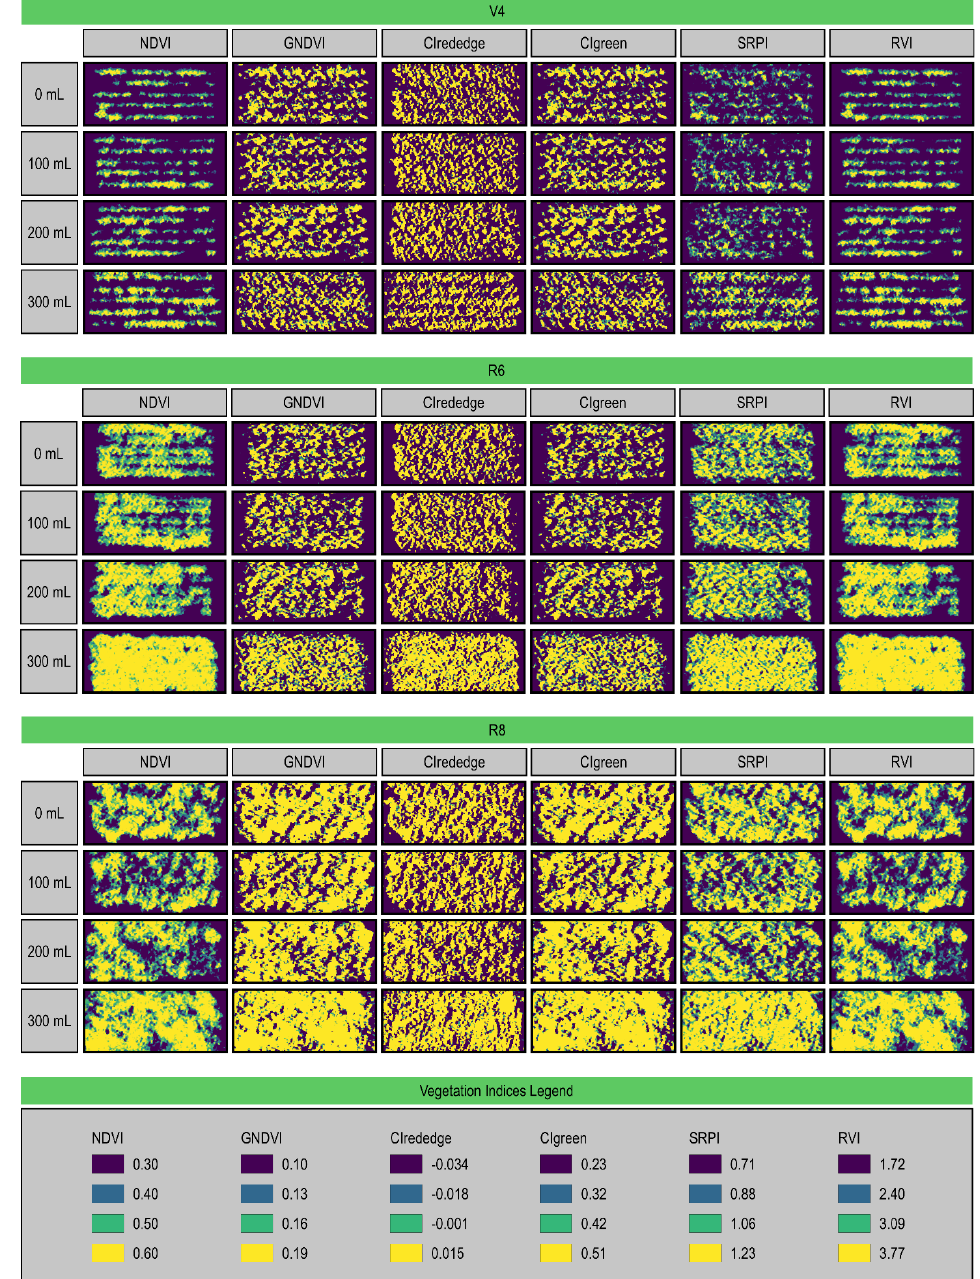
Figure 4. Remote top-down mapping of the application of phosphate-solubilizing bacteria for biofertilization of the common bean.